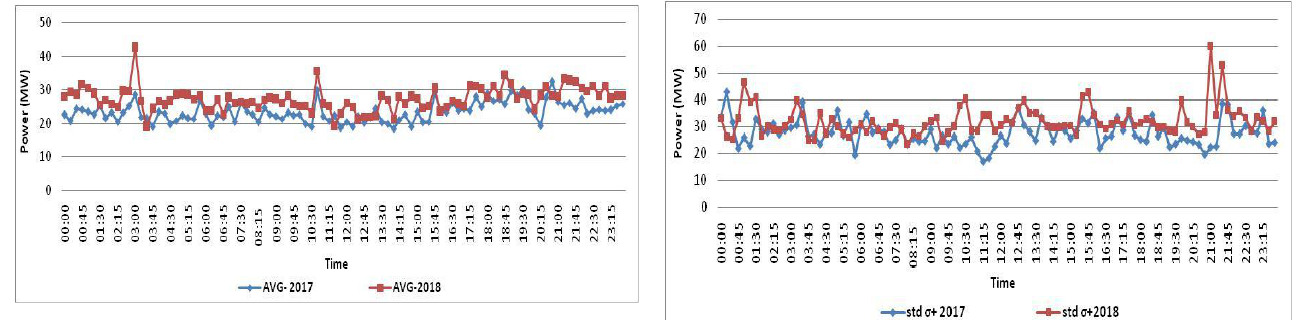
Figure 8. Comparison between average values of upward power ramps in 15 min interval at each observation time t for the years 2017 and 2018.